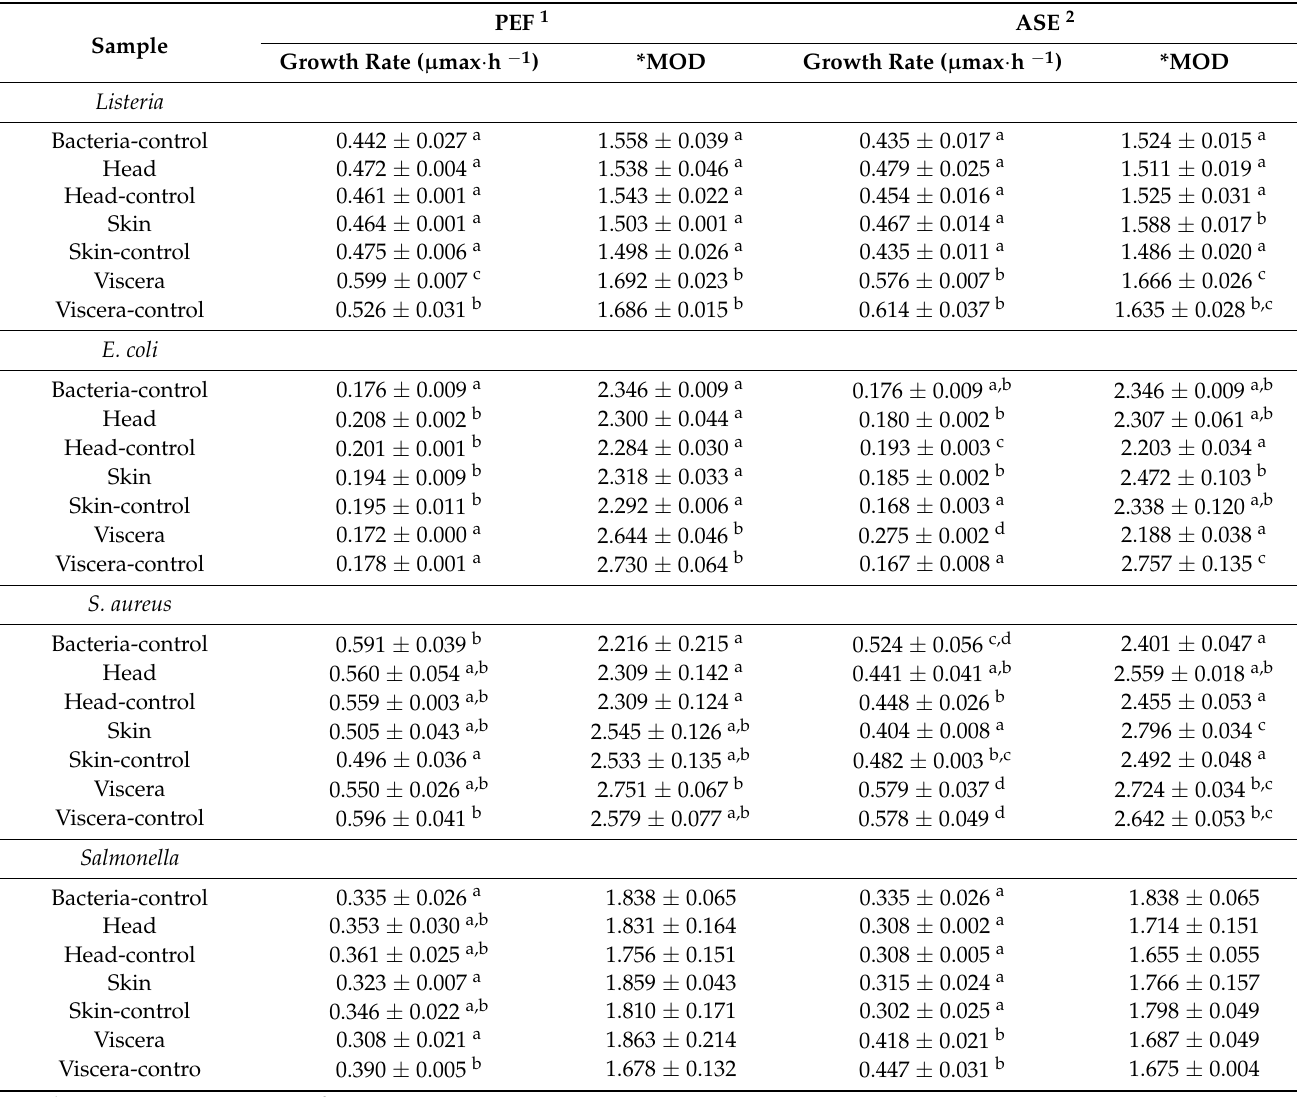
Table 3. Effect of rainbow trout extracts on the growth rate and maximal optical density of four pathogenic bacteria strains.